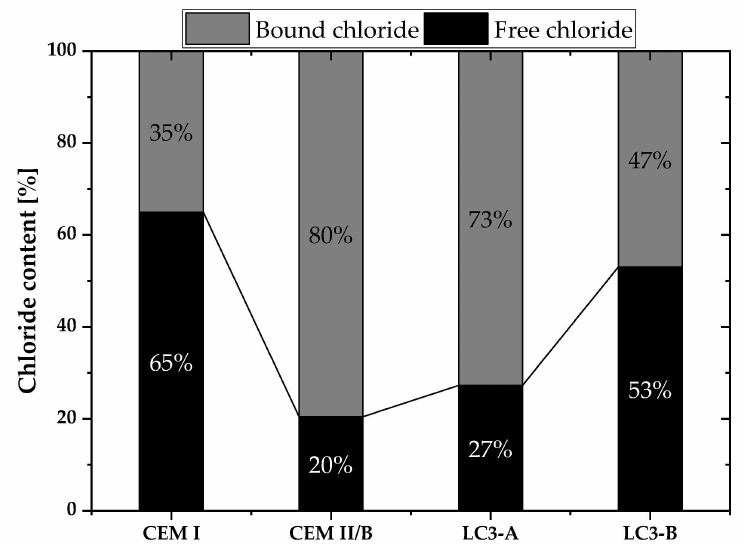
Figure 12. Bound and free chloride content at the depth of 10 mm from exposed surface towards salt